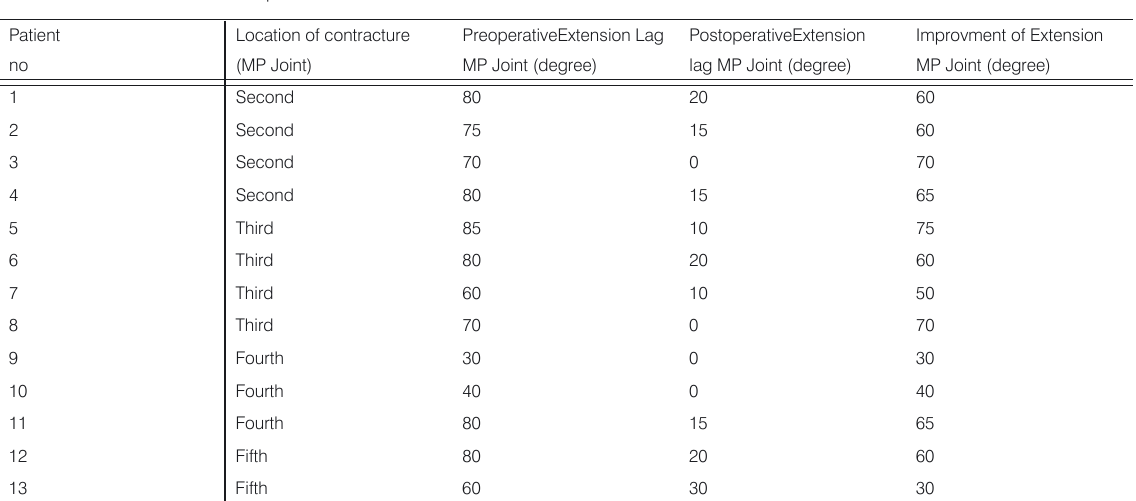
Table 2. Functional results of